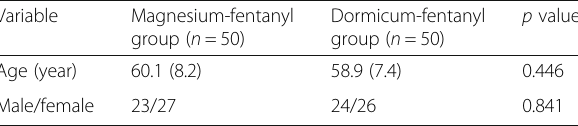
Table 1 Patients ’ characteristics in both study groups Variable